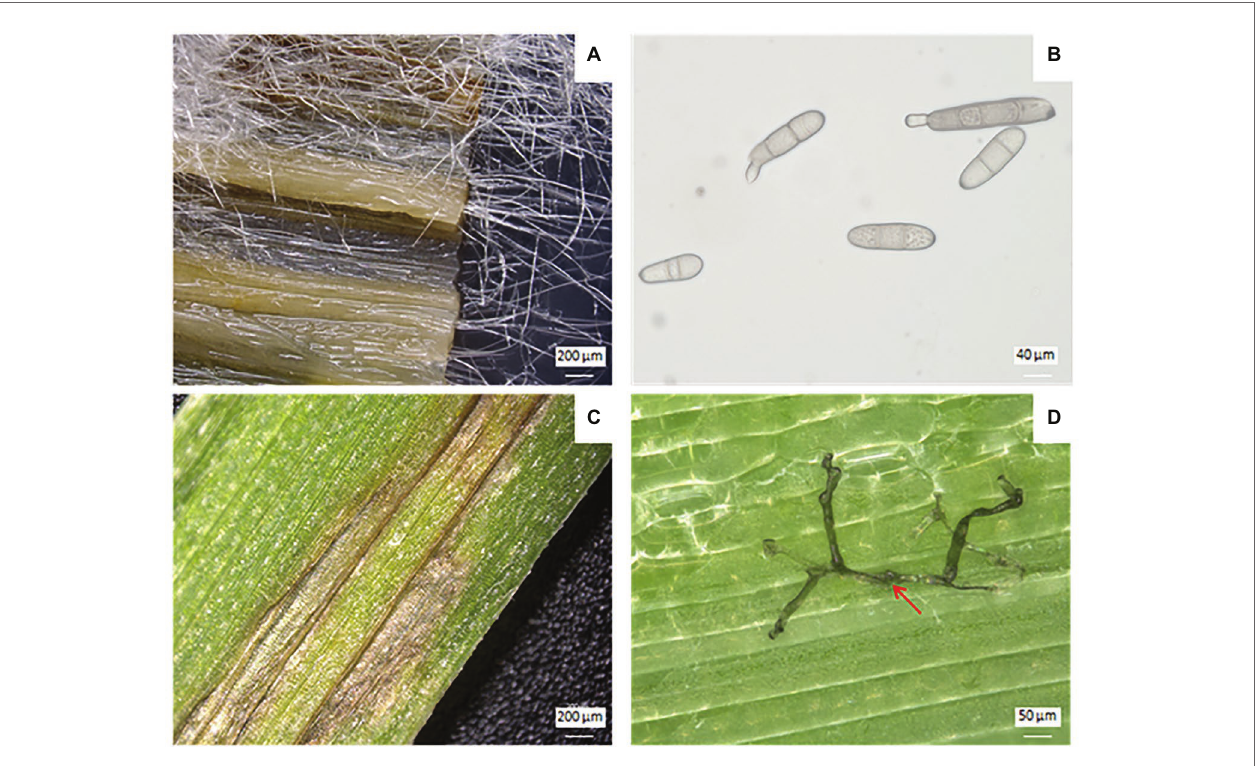
FIGURE 5 | Vegetative and reproductive forms of P. teres and its symptoms on barley leaves. Mycelium of P. teres in barley leaf deposited on PDA medium (A) , conidia of P. teres (B) , chlorosis and necrosis symptoms on barley leaf caused by P. teres (C) , and penetration of mycelium (red arrow) through barley leaf (D)